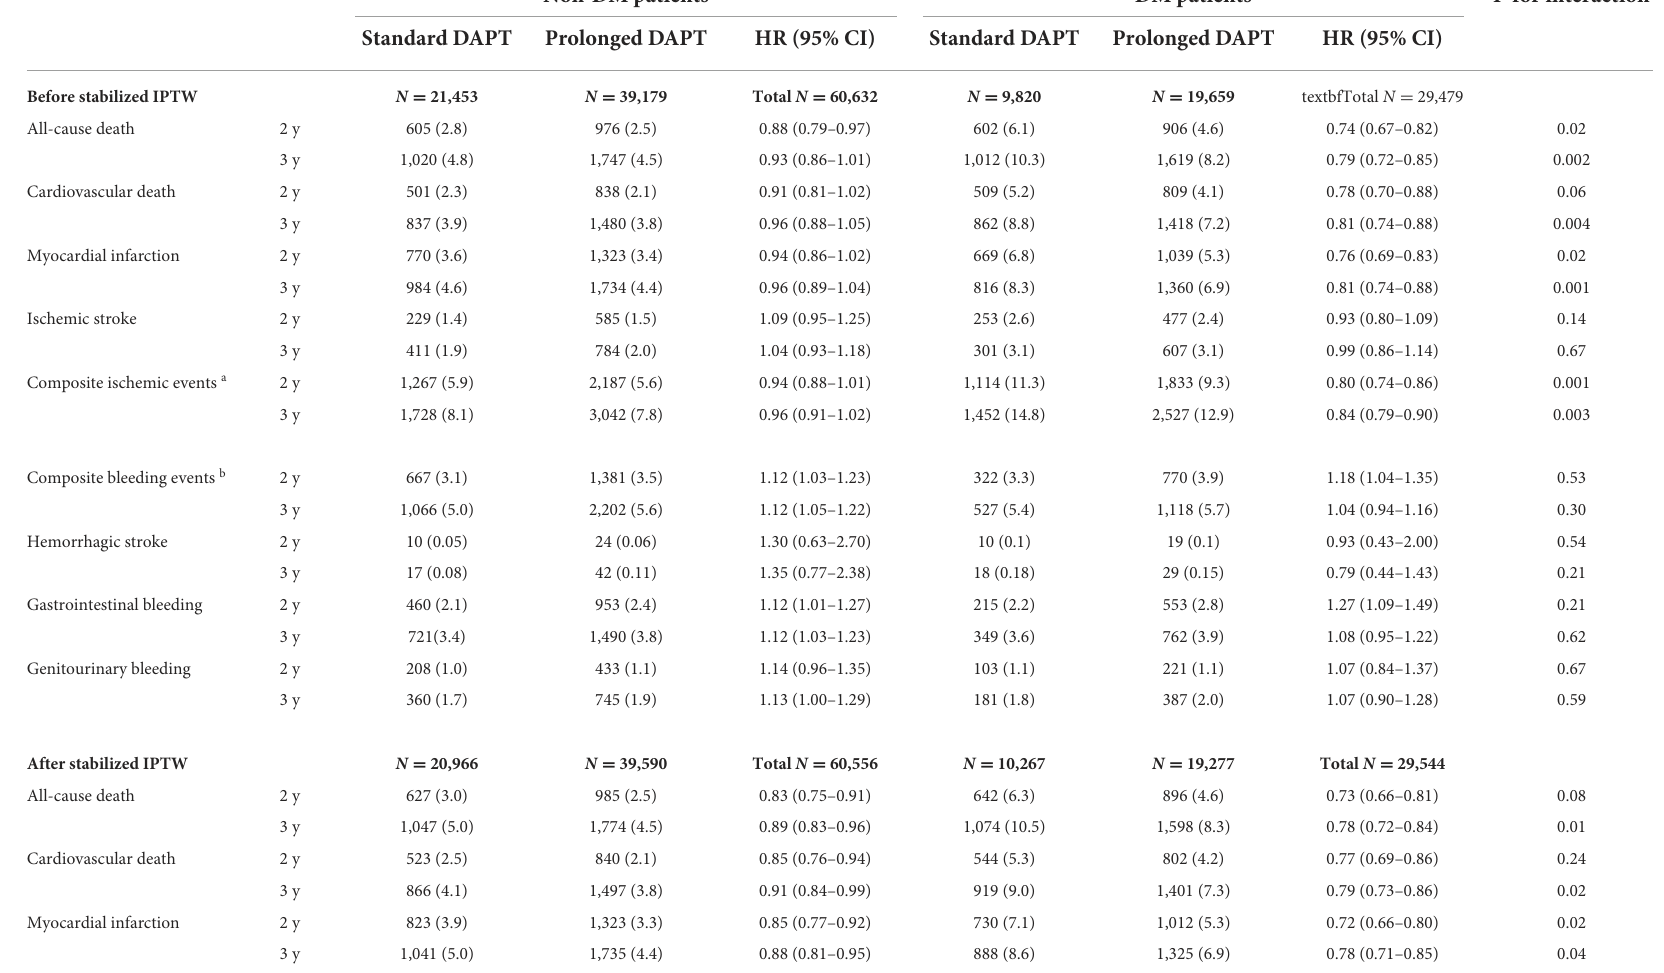
TABLE 2 Risks of primary and secondary outcomes before and after stabilized